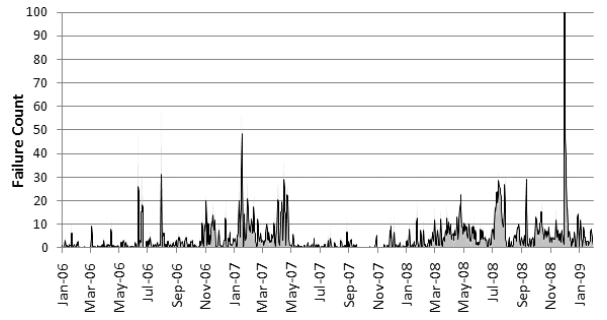
Figure 4. Long-term ( > 6h) failures vs. date.